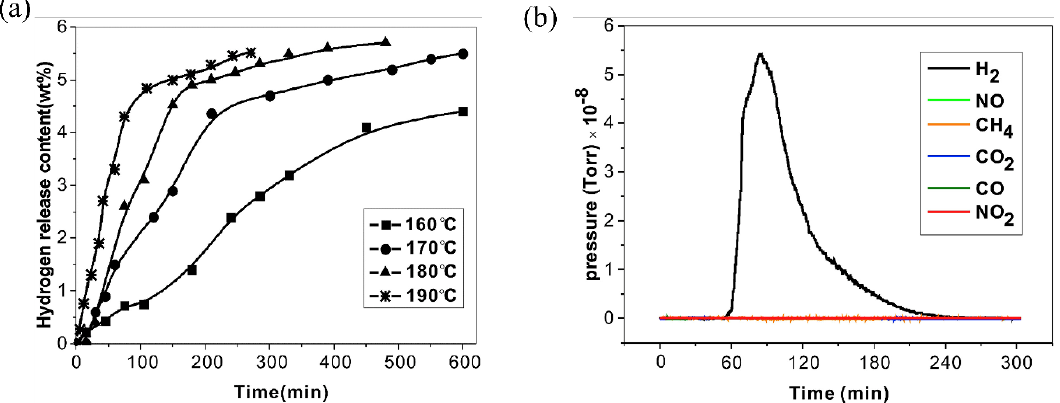
Figure 9. ( a ) The time-dependent hydrogen release curves of 8H-NMID dehydrogenation at different temperatures. ( b ) DSMS spectra of hydrogen gas released from the dehydrogenation process at 180 °C. Reprinted with permission from [90].